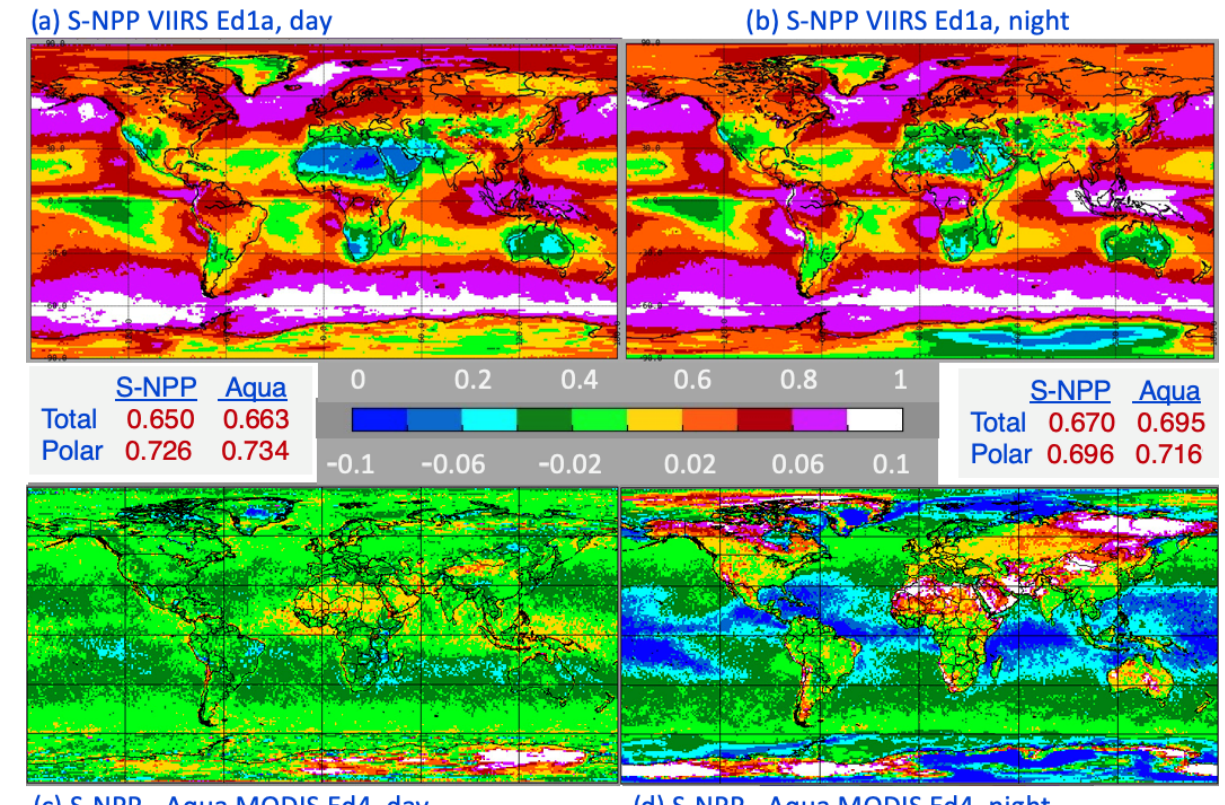
Figure 2. Mean 2013 cloud fractions from CV1S for ( a ) day and ( b ) night with the differences between CV1S and CM4 for ( c ) day and ( d ) night.